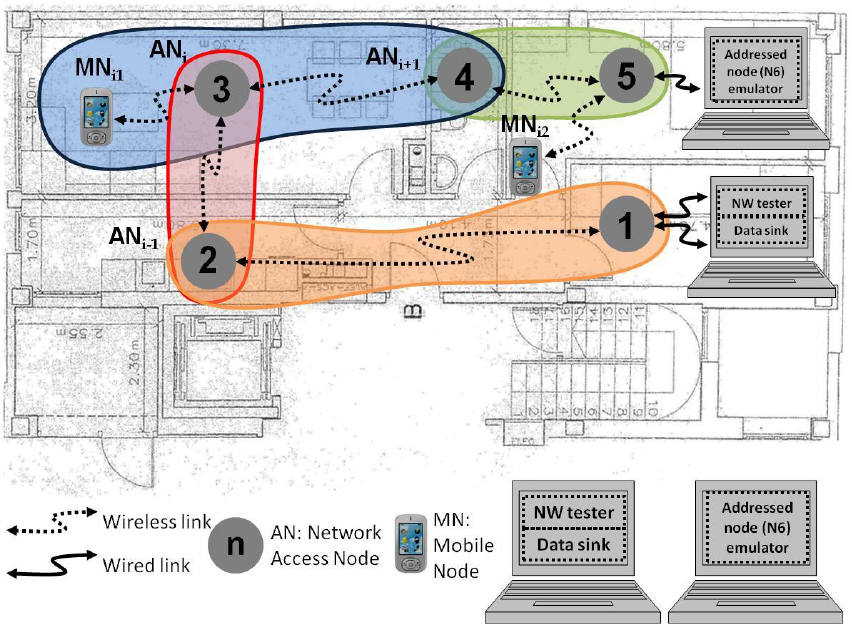
Figure 1. Example of multi-hop network deployment for intelligent systems (distances expressed in